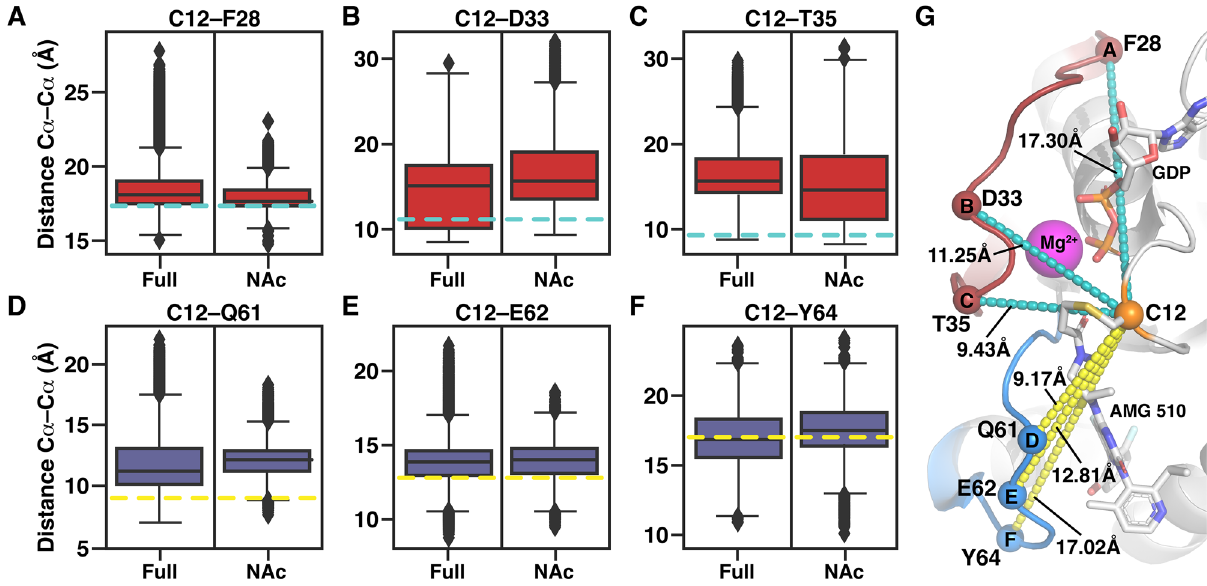
Figure 4. Distances of switch regions to selected switch-I ( A – C ) and switch-II ( D – F ) residues. The corresponding locations of the monitored Cα atoms (spheres) and their distances in the AMG 510 crystal structure (PDB ID: 6oim) are illustrated with cyan and yellow dashed lines in A – F . The black horizontal line in the box represents the median. Box displays the quartiles of the dataset (25%–75%) and whiskers the rest of the data with maximum 1.5 IQR. Outliers are indicated with black diamonds. ( G ) Monitored distances represented in the KRAS(G12C)–AMG 510